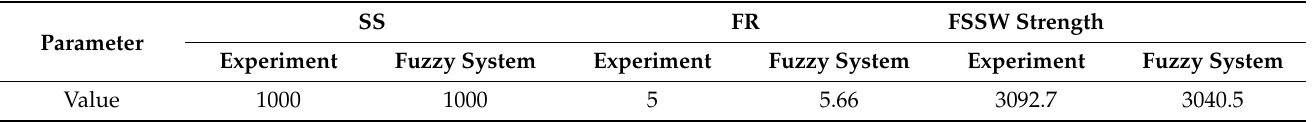
Table 15. The optimum values for dynamic welding parameters of experiment and fuzzy